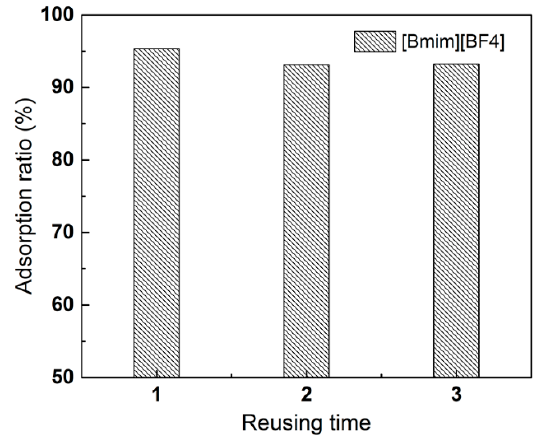
Figure 9. Effect of reusing times on the adsorption of ionic liquid ([Bmim][BF 4 ]) onto ion-exchange resin (Amberlite IR 120Na).